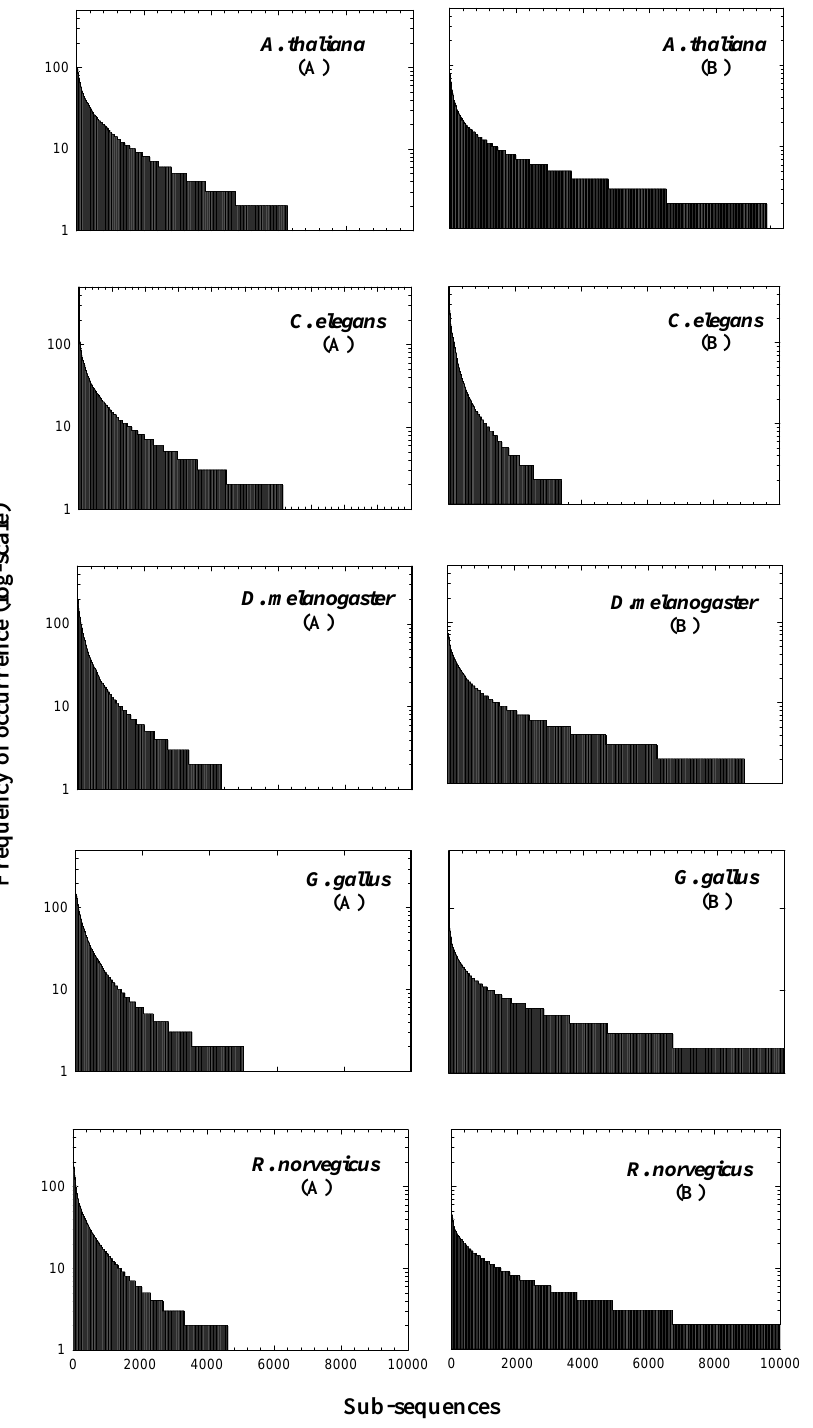
Fig 2. Vertical bar plots of the frequency of occurrence (log scale) of the unique sub-sequences (arranged in descending order) in each set (first 65,535 sub-sequences considered), of size ten of the respective organisms plotted against the number of corresponding sub-sequences (represented as numbers in linear scale) for the (A) donor and (B) acceptor splice site regions. Scales of the axes are shown similar for all the organisms for the ease of comparison. The total area in each of the graphs is the